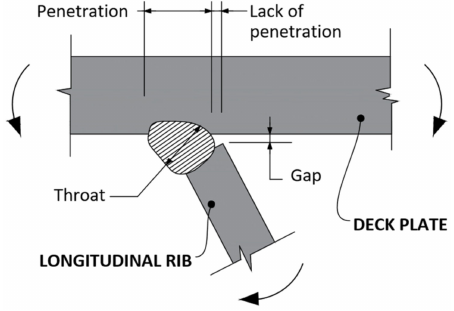
Figure 3. Rib-deck connection